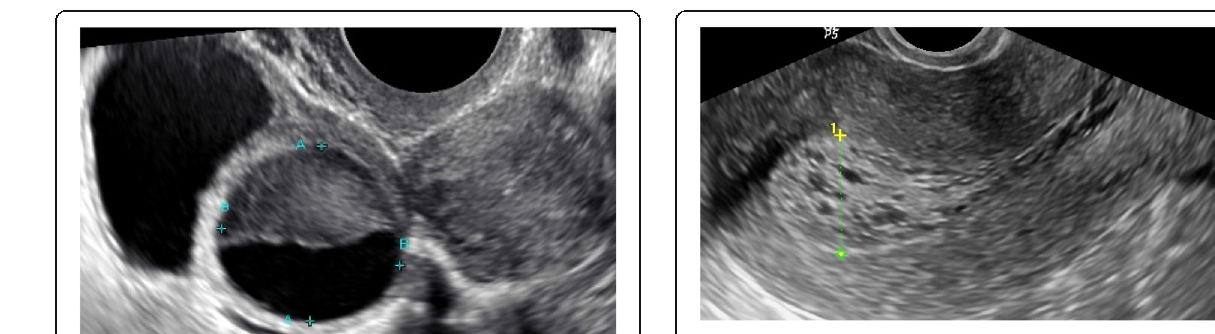
Fig. 3 Sagittal view by TVUS showing a thickened homogenous echogenic endometrium, measuring about 12.5 mm in maximal anteroposterior diameter (A), with regular borders, preserving subendometrial halo and few variable sized cysts. Histopathology result of the endometrial biopsy was consistent with endometrial